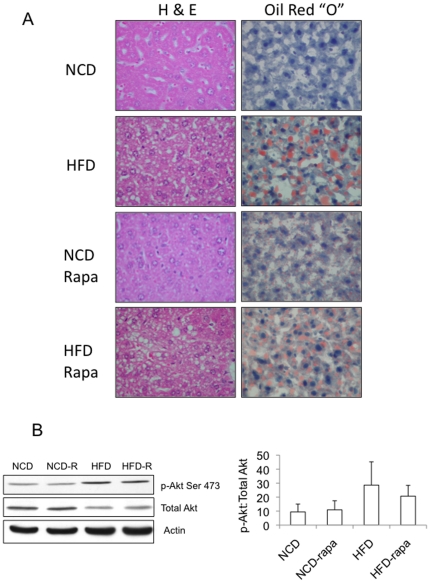
Histologic and biochemical effects of rapamycin on HFD-induced steatosis.A) Examples of histology (H&E) and Oil Red “O” staining of the livers procured from animals described in Figure 4. NCD, normal chow diet; HFD, high-fat diet; Rapa, rapamycin. Magnification, 400X. B) Western blots of representative liver lysates from each of the four groups shown in (A) highlighting the effects of chronic rapamycin on Akt(Ser473) phosphorylation. The average ratios of band intensities (Image J) between phospho- and total-Akt are summarized in the graph (n of 5 per group).